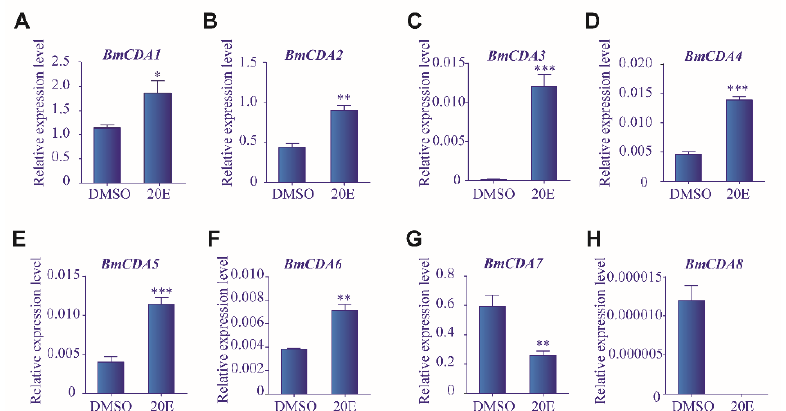
Figure 5. Effect of 20-hydroxyecdysone (20E) on the expression of eight Bombyx mori chitin deacetylases ( BmCDAs ). The mRNA expression levels of BmCDAs were detected using RT-qPCR after injection of 20E for 24 h. Dimethyl sulfoxide (DMSO) was used in the control group. * p < 0.05, ** p < 0.01, *** p < 0.001 vs. control.